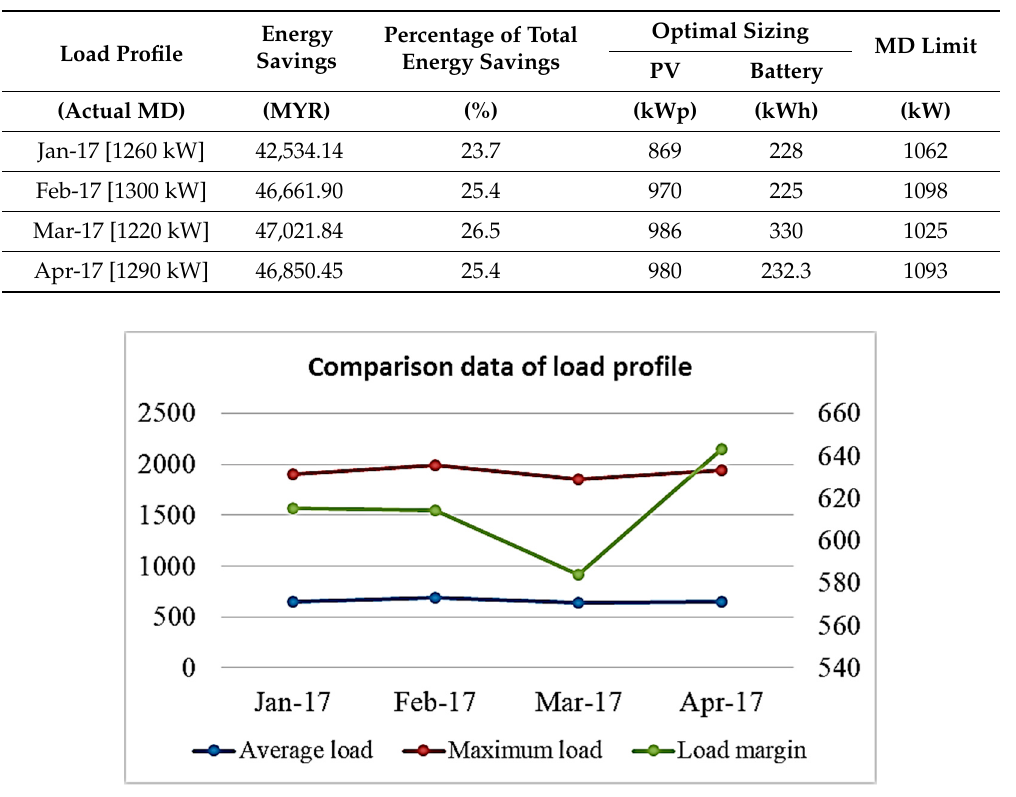
Figure 10. Comparison data analysis of load profile.